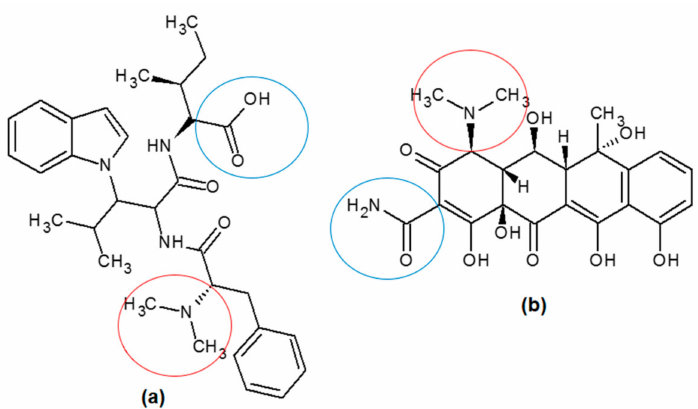
Figure 13. The structures of ( a ) ixorapeptide II and ( b ) OTC, which have a similar functional group, could be the responsible part of the compounds toward MMP9